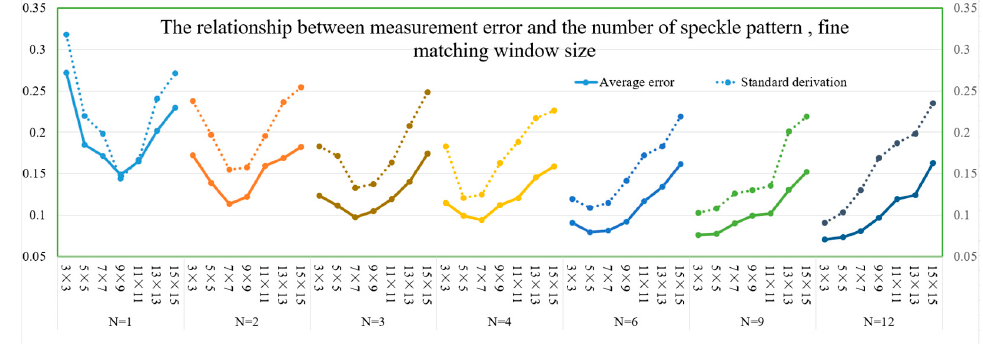
Figure 12. Comparison of reconstruction error obtained between the projected pattern numbers, N, and fine matching window, w f . When N continues to increase, the reconstruction error decreases accordingly. Meanwhile, the optimal window size will also drop.